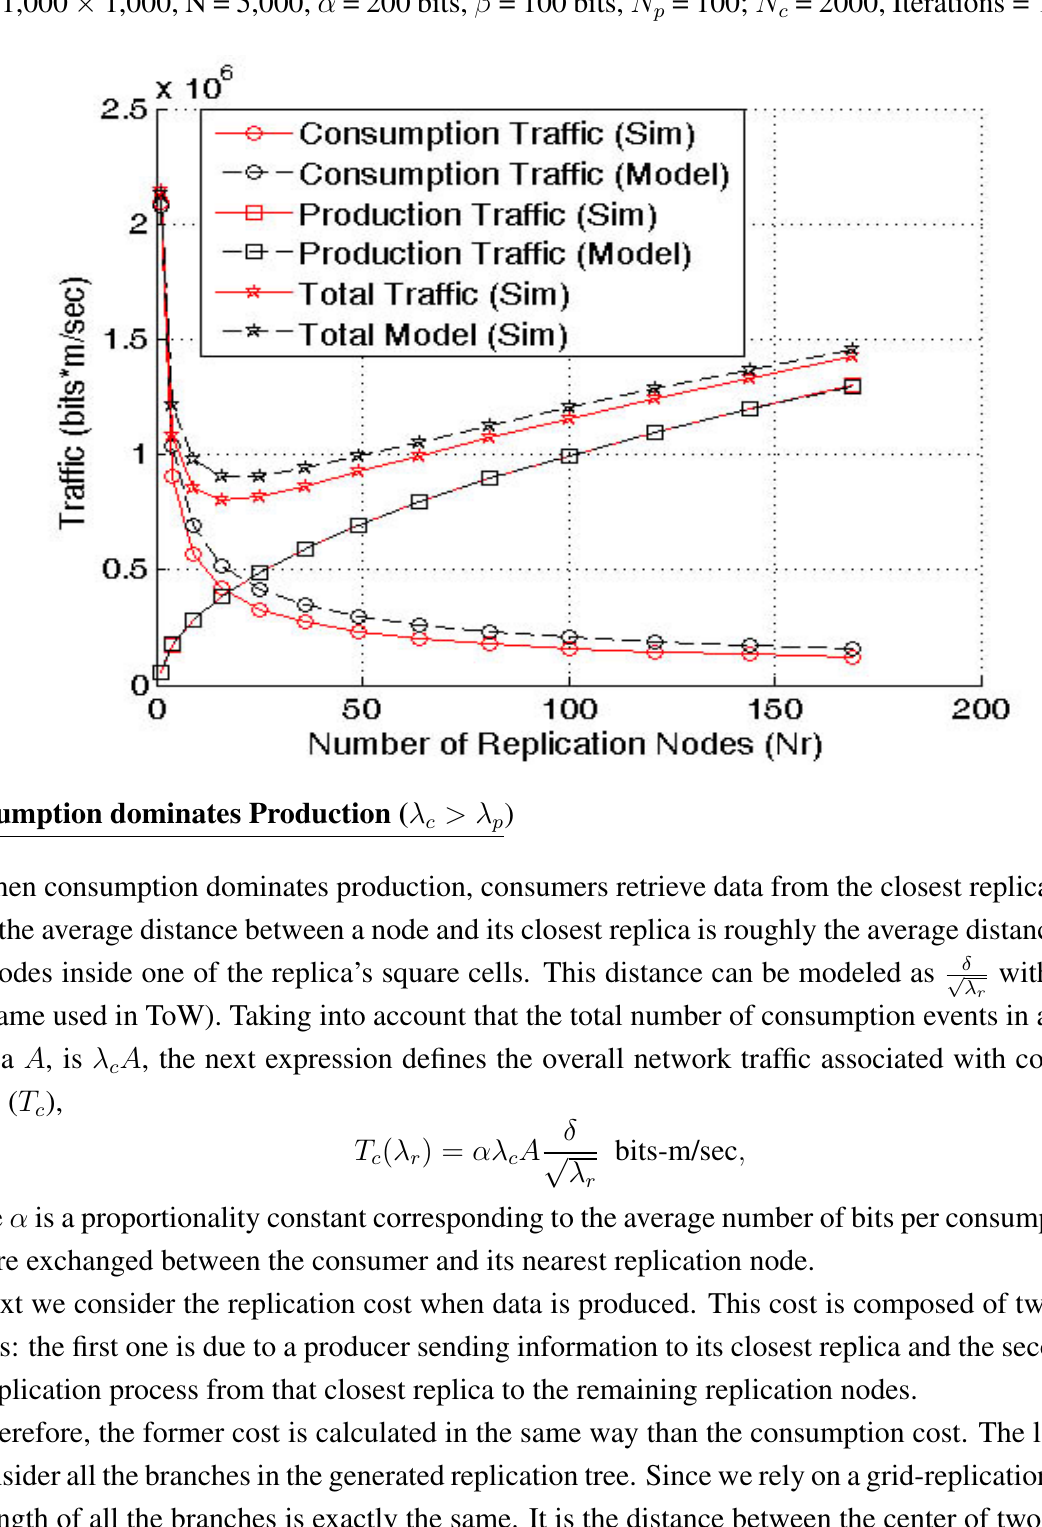
Figure 7. Overall network traffic generated by QAR using different number of replicas (A